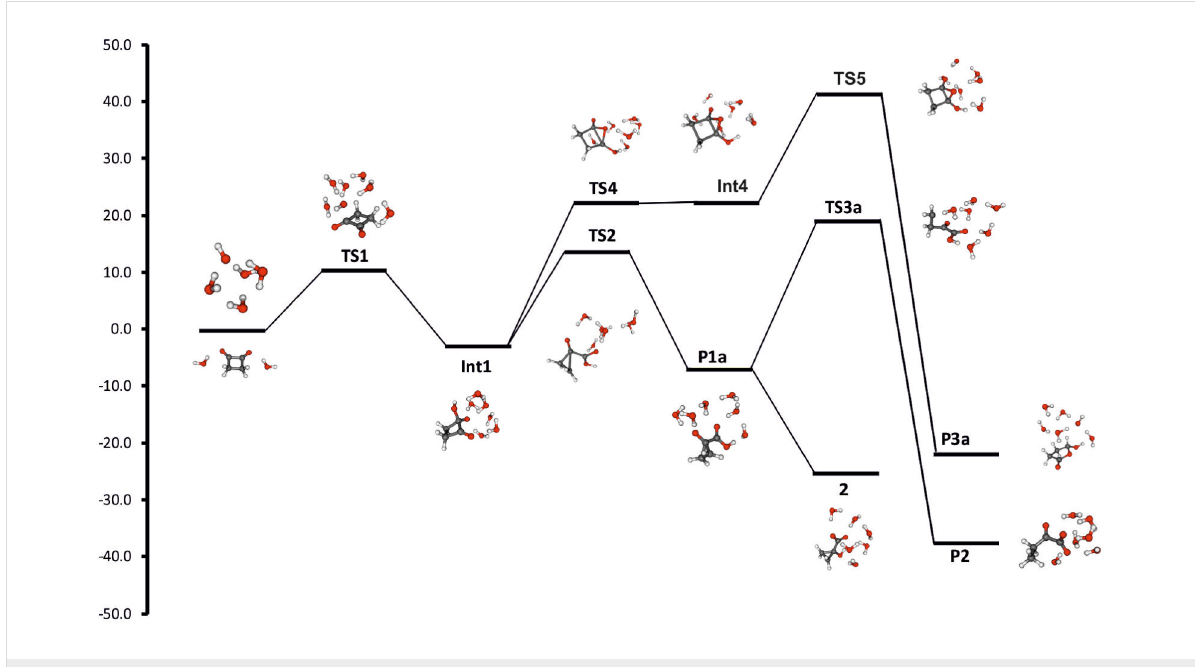
Figure 1: CEPA-1/def2-QZVPP calculated reaction paths for the reaction of 1 ·(H 2 O) 2 + [OH(H 2 O) 4 ] – .